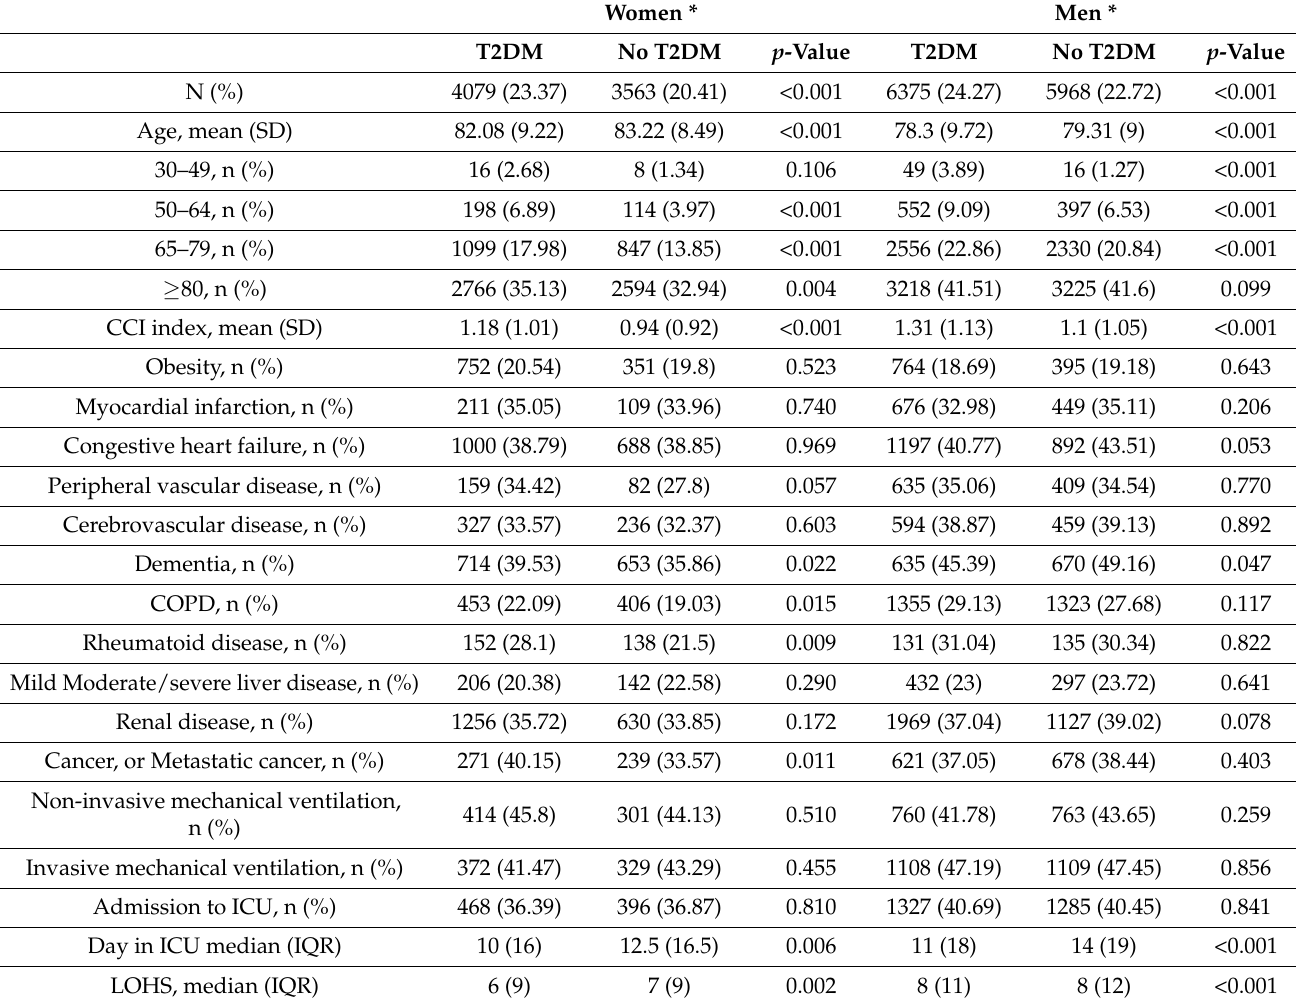
Table 4. In-hospital mortality after matching for women and men with COVID-19 in Spain, 2020, according to T2DM